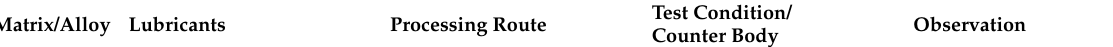
Table 2. Solid lubricants in the intermetallic matrix and their extreme condition